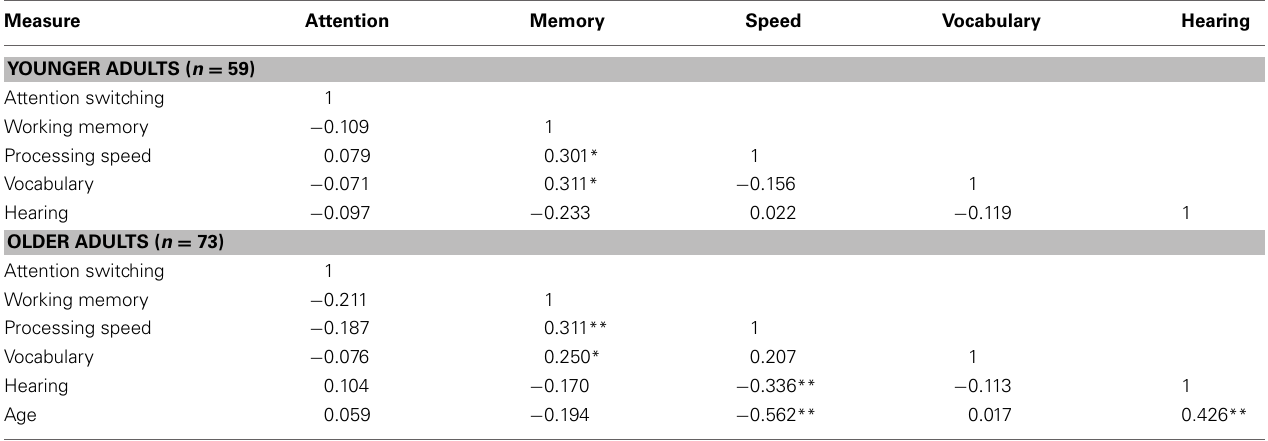
Table 2 | Pearson’s correlation coefficients between measures of cognitive, linguistic, and auditory functioning per age